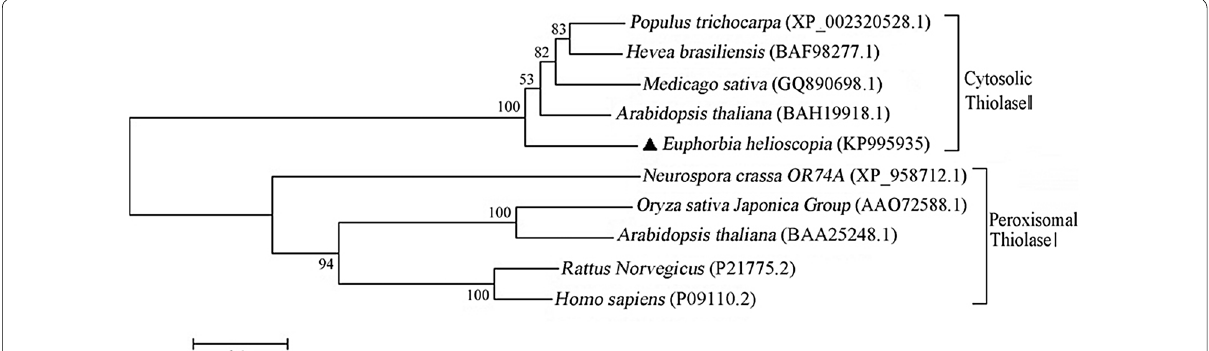
Fig. 3 The phylogenetic tree of acetoacetyl-CoA thiolase (AACT) was constructed with the neighbor-joining method of the program MGEA 6.0 and reflected functional classification of thiolases by comparing with other species. Bootstrap value was calculated with 1000 permutations to identify the homogeneity of the analysis. Euphorbia helioscopia AACT exhibited highly functional similar with Populus trichocarpa , Hevea brasiliensis , Med- icago sativa and Arabidopsis Thaliana . And it displayed a more distant relationship with protein of AACT from other species, including Neurospora crassa OR74A, Oryza sativa Japonica Group, Arabidopsis thaliana , Rattus Norvegicus and Homo sapiens